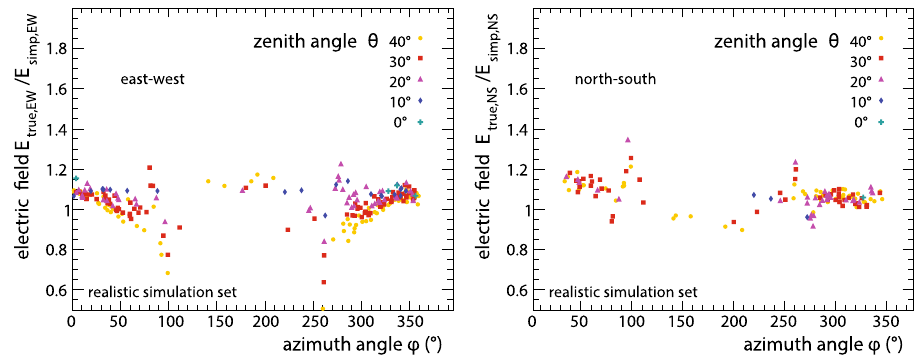
Fig. 6 Ratio between the true polarization components in individual antennas and the values reconstructed by the standard analysis pipeline of LOPES for end-to-end CoREAS simulations including all known detector effects for the east–west (EW) and north–south (NS) aligned